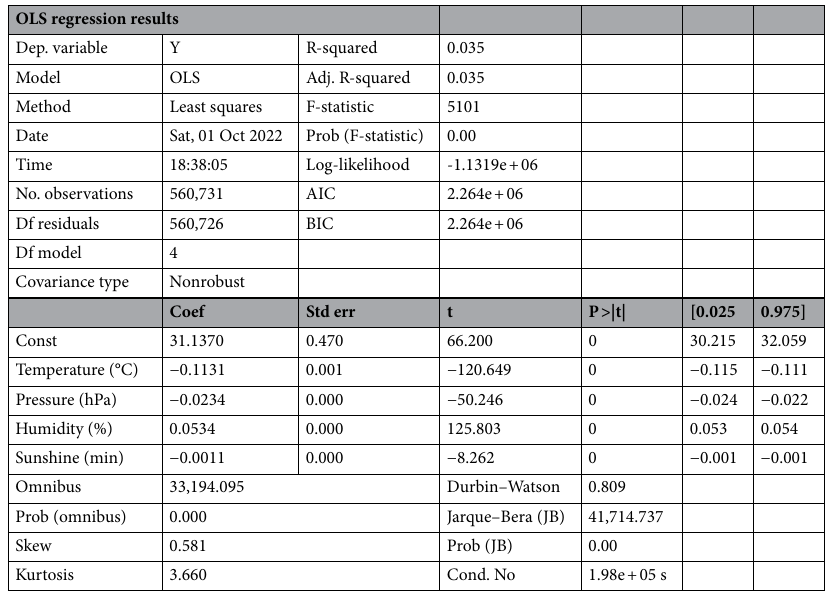
Table 2. Multivariate ordinary least squares (OLS) regression analysis of marathon average speed at each split distance as a function of the weather